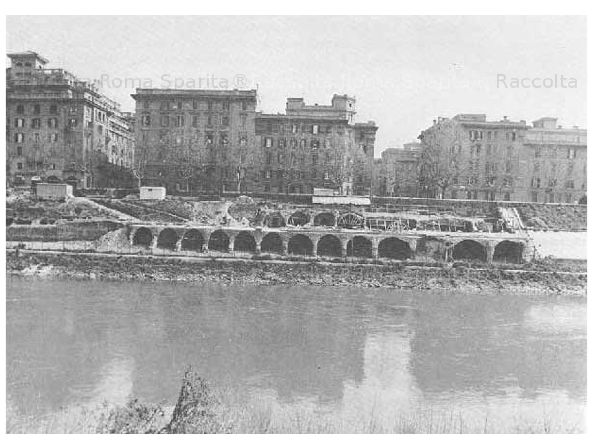
Figure 1. Historical photo taken during the excavations that brought to light the ruins of the Emporium . From the photographic archive of Roma